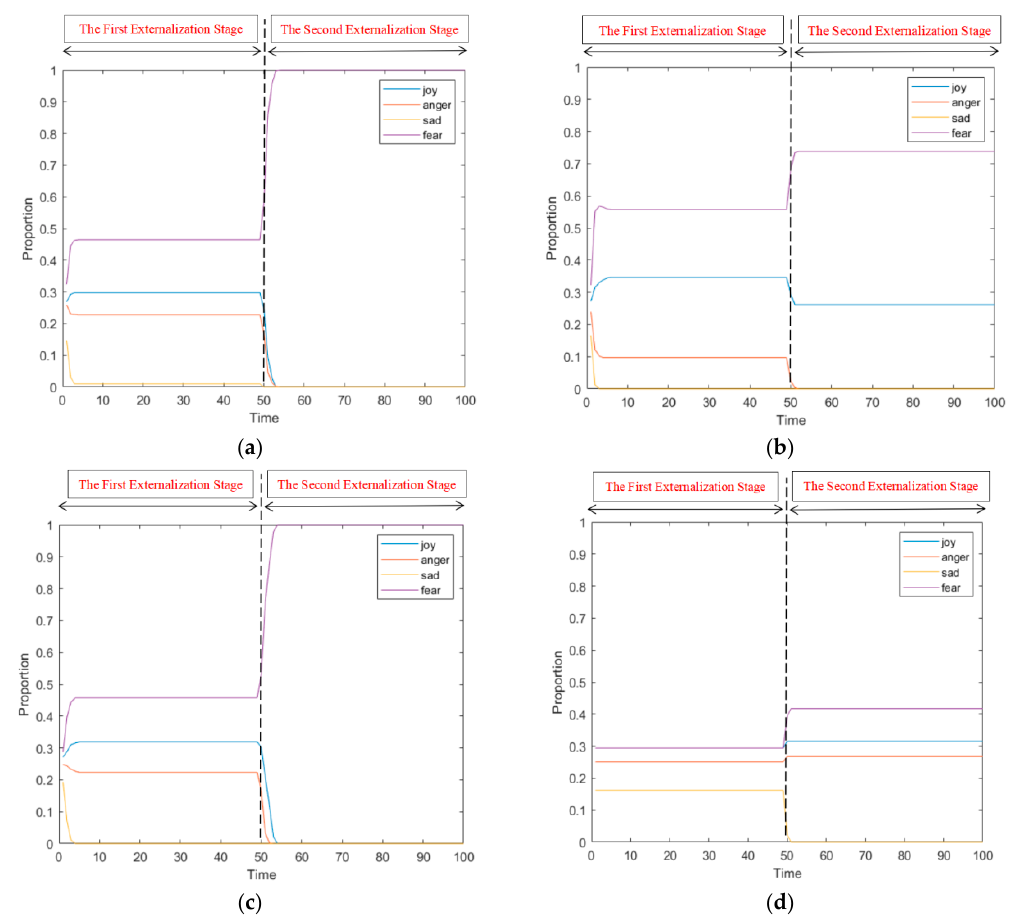
Figure 15. The changes of interactive nodes number under different network structure.